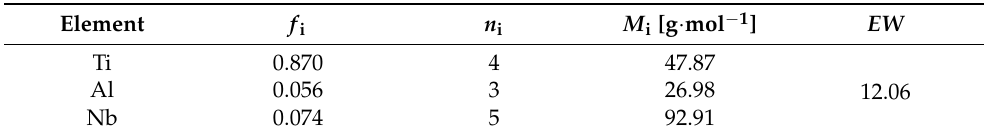
Table 3. Calculation of equivalent weight ( EW ) for the Ti-6Al-7Nb alloy in saline solution at 37 ◦ C according to ASTM G102—89(2015)e1